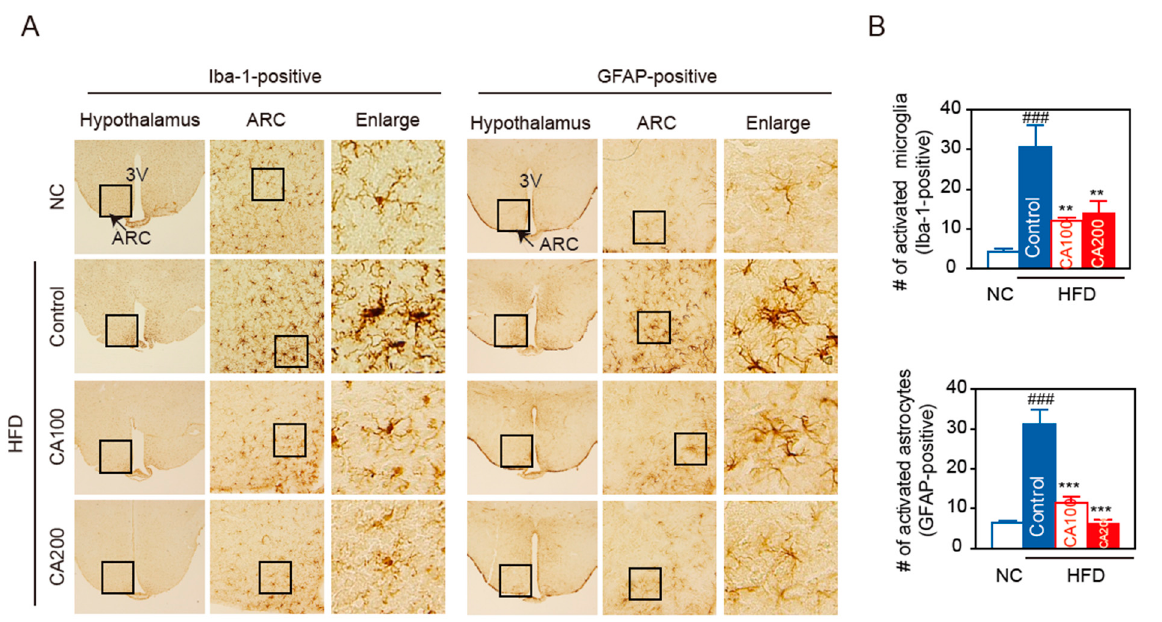
Figure 7. CA attenuates HFD-induced hypothalamic inflammation. ( A ) Representative images and higher magnification inset of hypothalamus of HFD-fed mice. Hypothalamic sections were immuno-stained with Iba-1 or GFAP antibodies. The arcuate nucleus (ARC) area (arrow, inset box) and the third ventricle (3V) are indicated. Box area in ARC was enlarged to view the cellular morphology. ( B ) Quantification of activated microglia (Iba-1 positive cells) and activated astrocytes (GFAP-positive cells) in the ARC. Data are expressed as the mean ± SEM ( n = 6). ### p < 0.001 vs. NC, and ** p < 0.01, and *** p < 0.001 vs. HFD-control. NC, normal chow; Control, HFD-control; CA100, HFD plus CA 100 mg/kg; CA200, HFD plus CA 200 mg/kg.